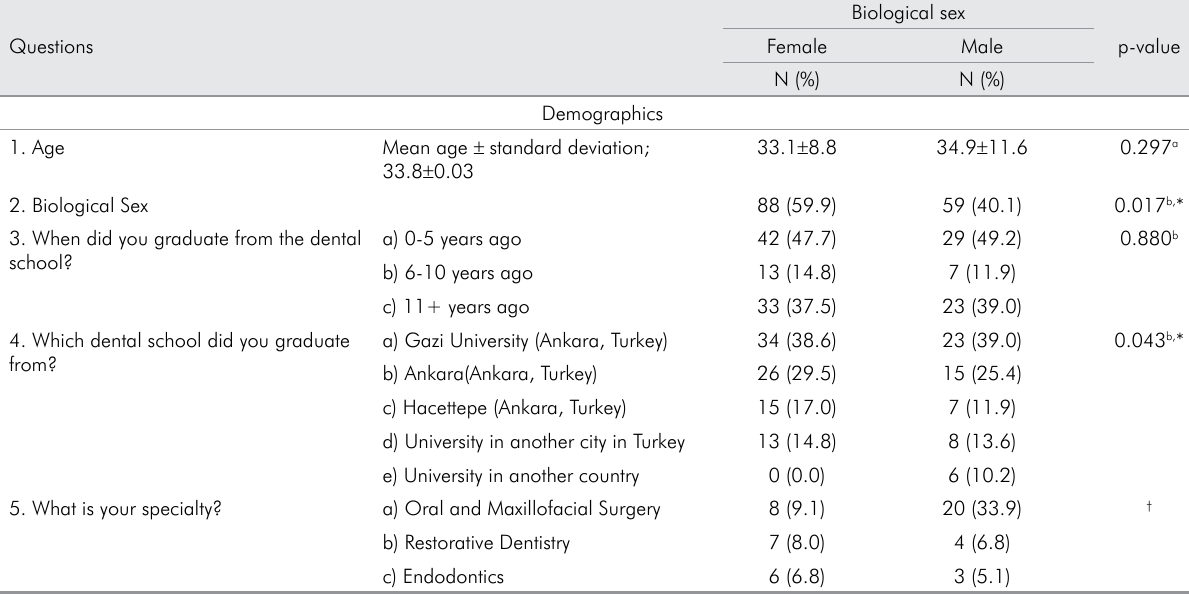
Table 2. Descriptive statistical results of the questionnaire, according to biological